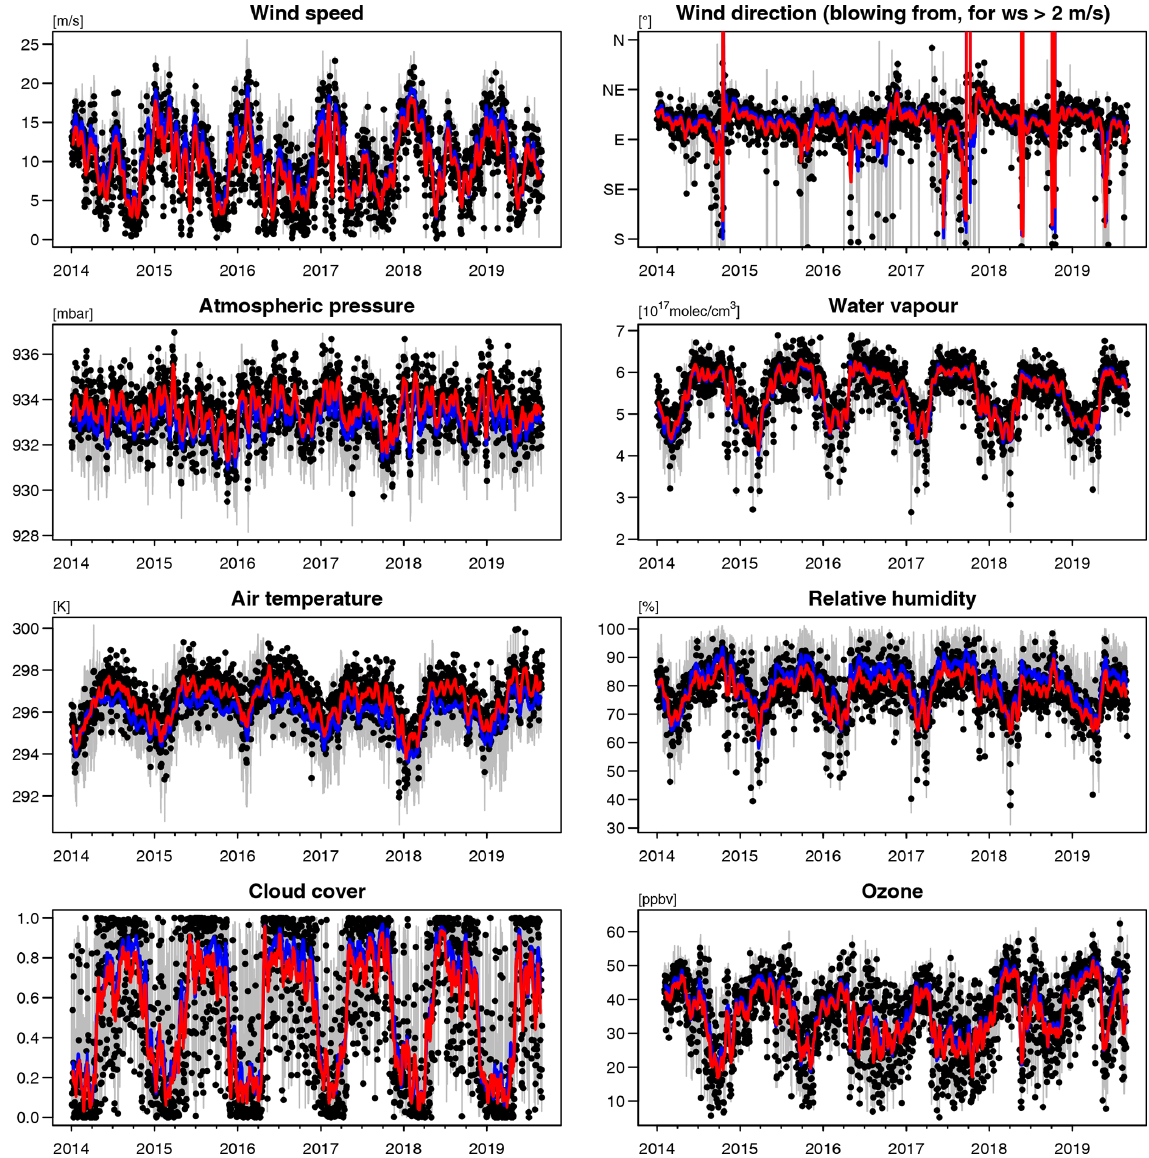
Figure 2. Meteorological conditions at Masaya volcano retrieved from ECMWF ERA-Interim data with resolutions of 6h and 1 ◦ × 1 ◦ and interpolated to an altitude of 700ma.s.l. Grey lines: 6-hourly data. Blue lines: running means over the 6-hourly data with an averaging window of ± 7d. Black dots: around-noon (18:00UTC) data. Red lines: running means over the around-noon data with an averaging window of ± 7d. Absolute variations are almost the same for the full data set and the around-noon data only, except for the air temperature and the relative humidity, which follow their expected diurnal cycles.